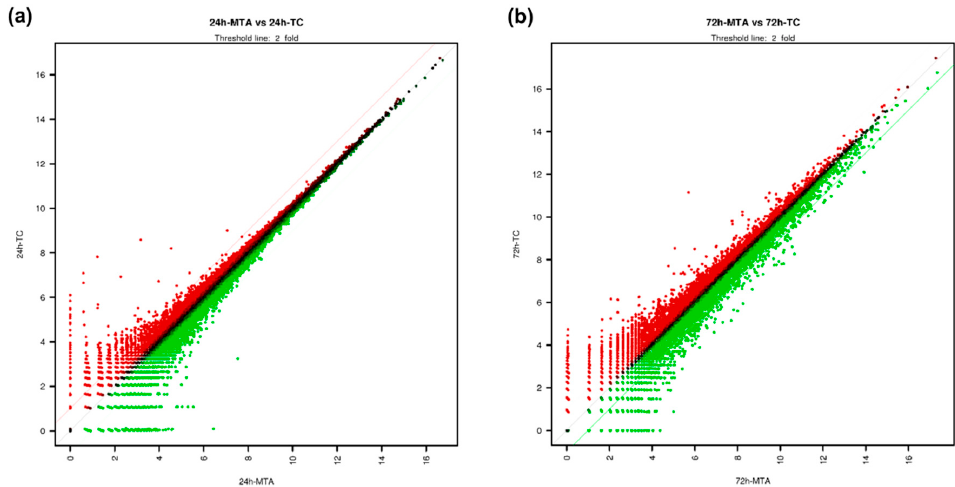
Figure 2. Scatter plot analysis. In each plot, the central line passing through the origin indicates no di ff erence in expression between the cells stored for di ff erent materials. Values above the red line and below the green line indicate a more than 2-fold di ff erence. ( a ) Scatter plot analysis of MTA and TC for 24 h. ( b ) Scatter plot analysis of MTA and TC for 72